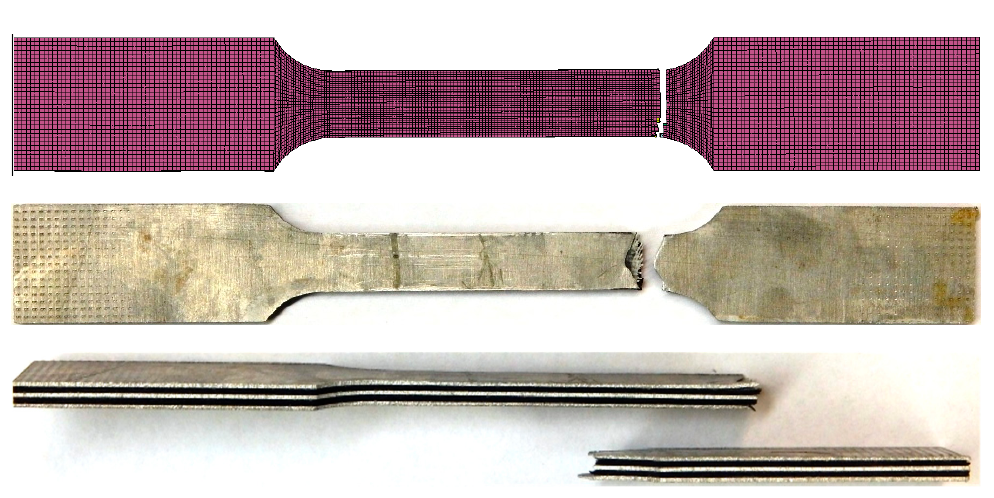
Figure 33. FEA and experimental failed specimen of CARALL-A having veil cloth layers.